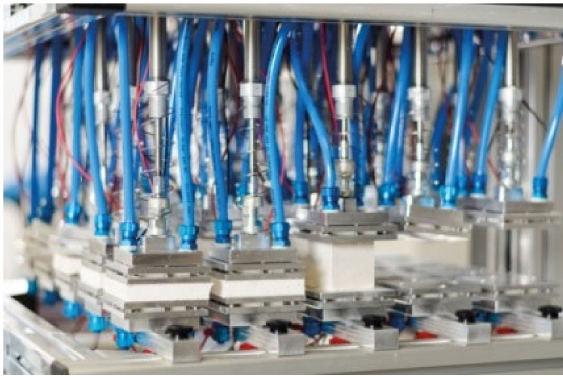
Figure 10. Peltier test